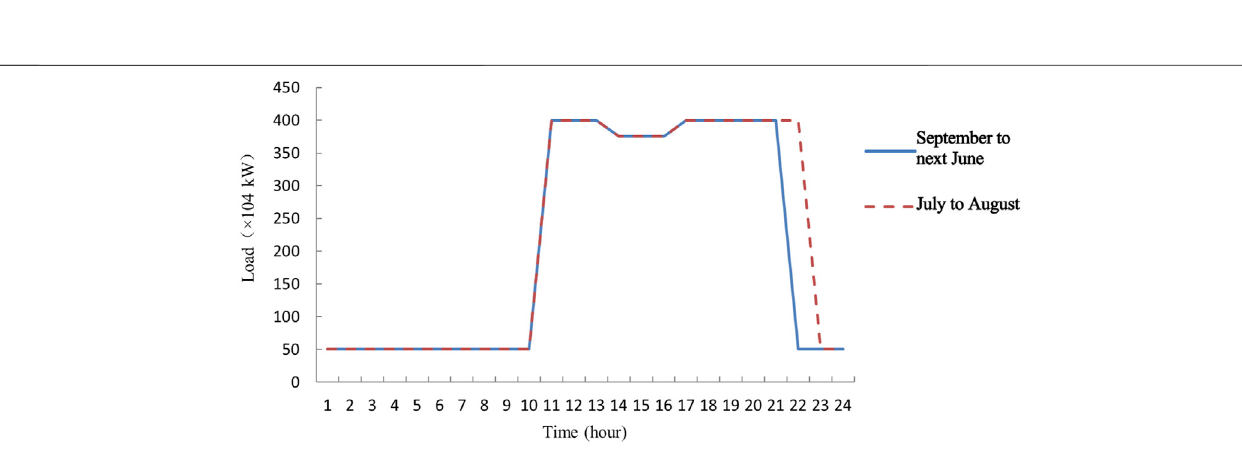
FIGURE 4 | Output characteristic curves of various power sources.